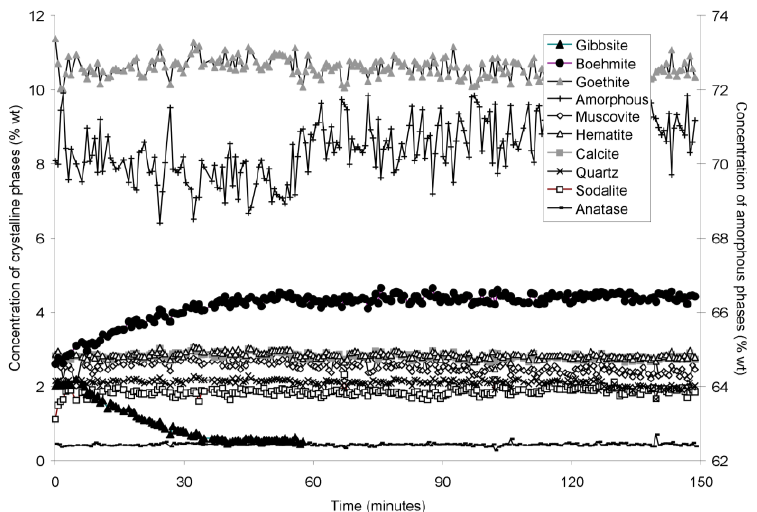
Figure 5. Concentration of crystalline and amorphous phases in bauxite residue slurry in capillary reaction vessels as a function of treatment time at 165 °C, as determined by Rietveld-based quantitative mineral analysis of X-ray diffractograms. Note that amorphous content is plotted on the secondary Y axis and represents contributions from X-ray amorphous minerals in bauxite residue, water in the slurry, and the fused silica capillary.